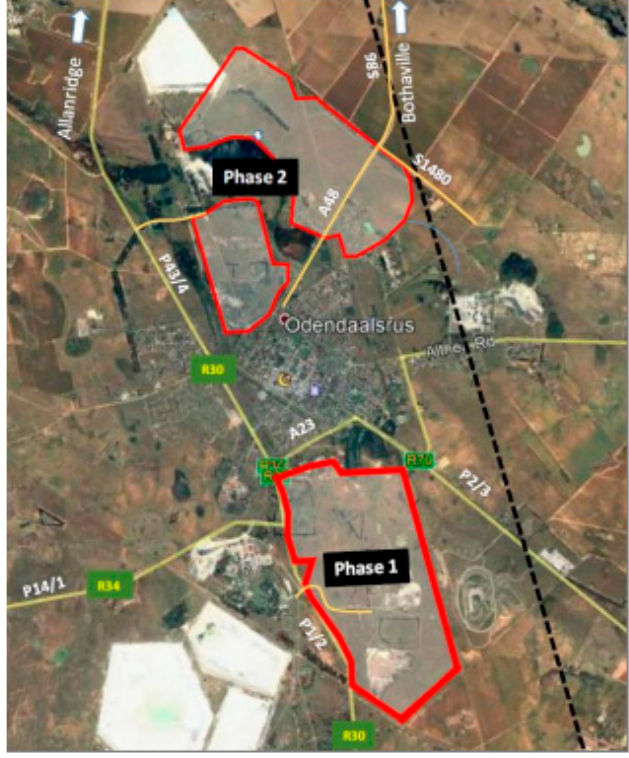
Figure 13. Locality map of the project’s Phase 1 and Phase 2 sites.